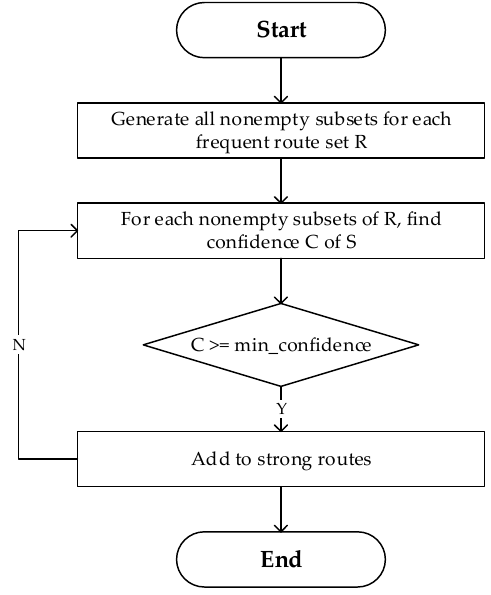
Figure 5. Flowchart of strong route generation.